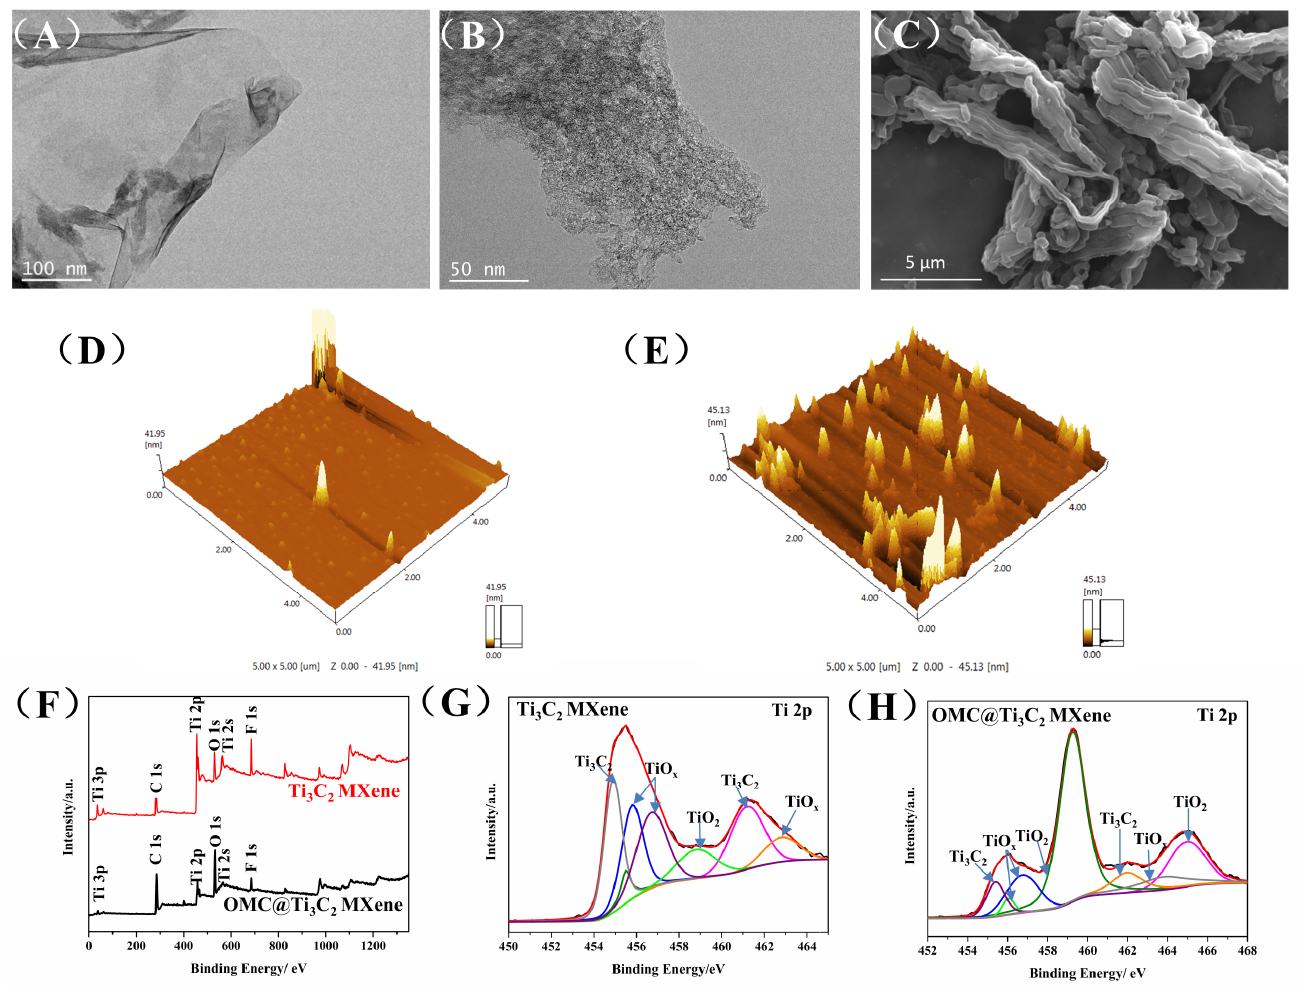
Figure 1. TEM image of Ti 3 C 2 MXene ( A ) and OMC ( B ); SEM image of OMC@ Ti 3 C 2 MXene ( C ); AFM images of Ti 3 C 2 MXene ( D ) and OMC@ Ti 3 C 2 MXene ( E ); XPS survey spectrum of Ti 3 C 2 MXene and OMC@ Ti 3 C 2 MXene ( F ); Ti 2p high-resolution spectra of Ti 3 C 2 MXene ( G ) and OMC@ Ti 3 C 2 MXene ( H